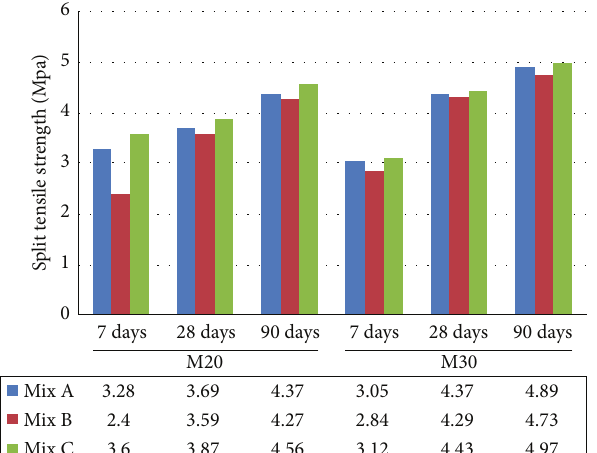
Figure 7: Comparative split tensile strength of Mix A, Mix B, and Mix C of M20 and M30 grade.